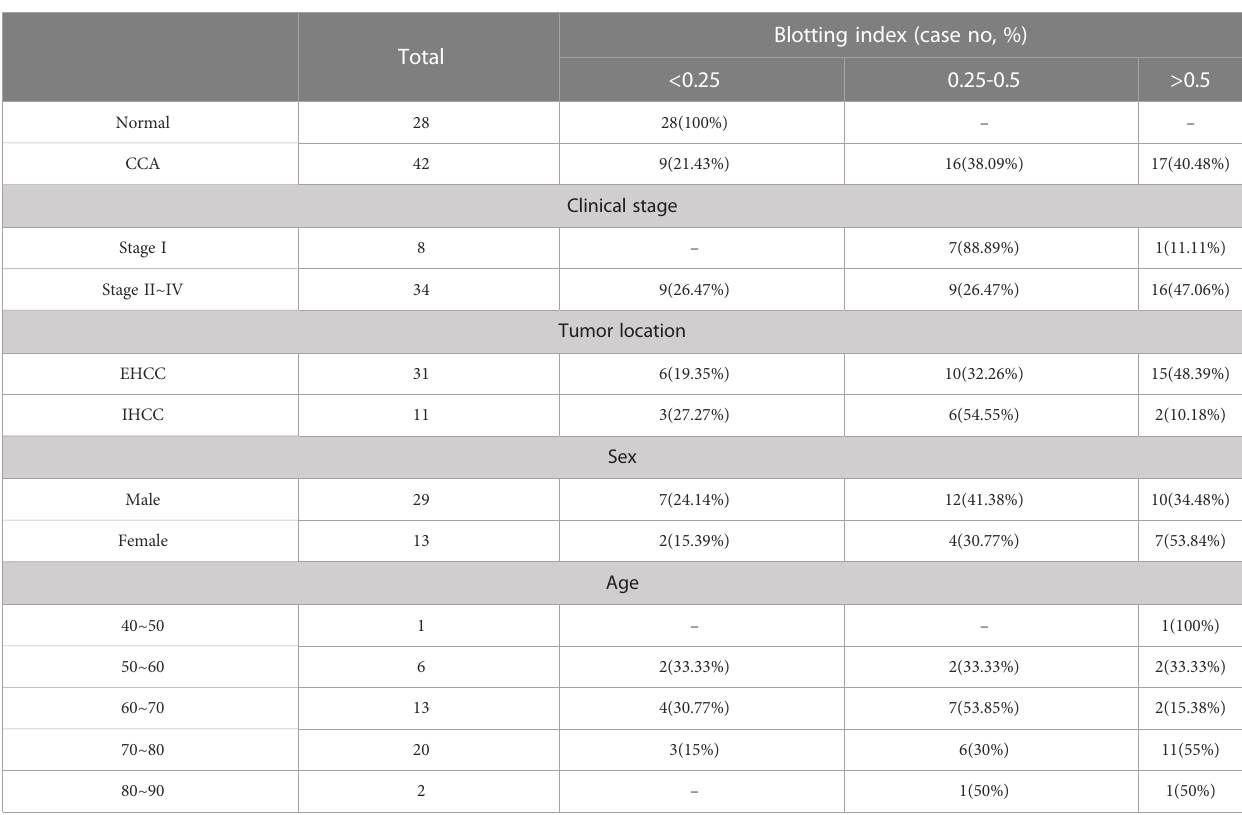
TABLE 1 Blotting index of CCA cases with tumor stage, location, sex, and age.